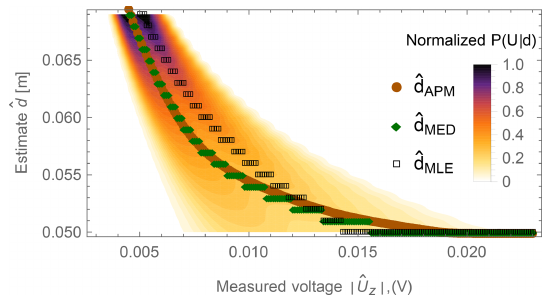
Figure 10. Mapping of the measured voltage | ˆ U Z | to the esti- mated distance ˆ d for the stochastic estimators ˆ d APM , ˆ d MED and ˆ d MLE overlaid with the normalized voltage probability distribution P ( U | d ) at any given distance d .